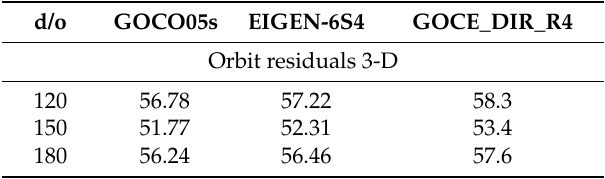
Table 5. GOCE orbit residuals based on dynamic orbit determination and kinematic orbit positions as observations. The statistics results are expressed by RMS in